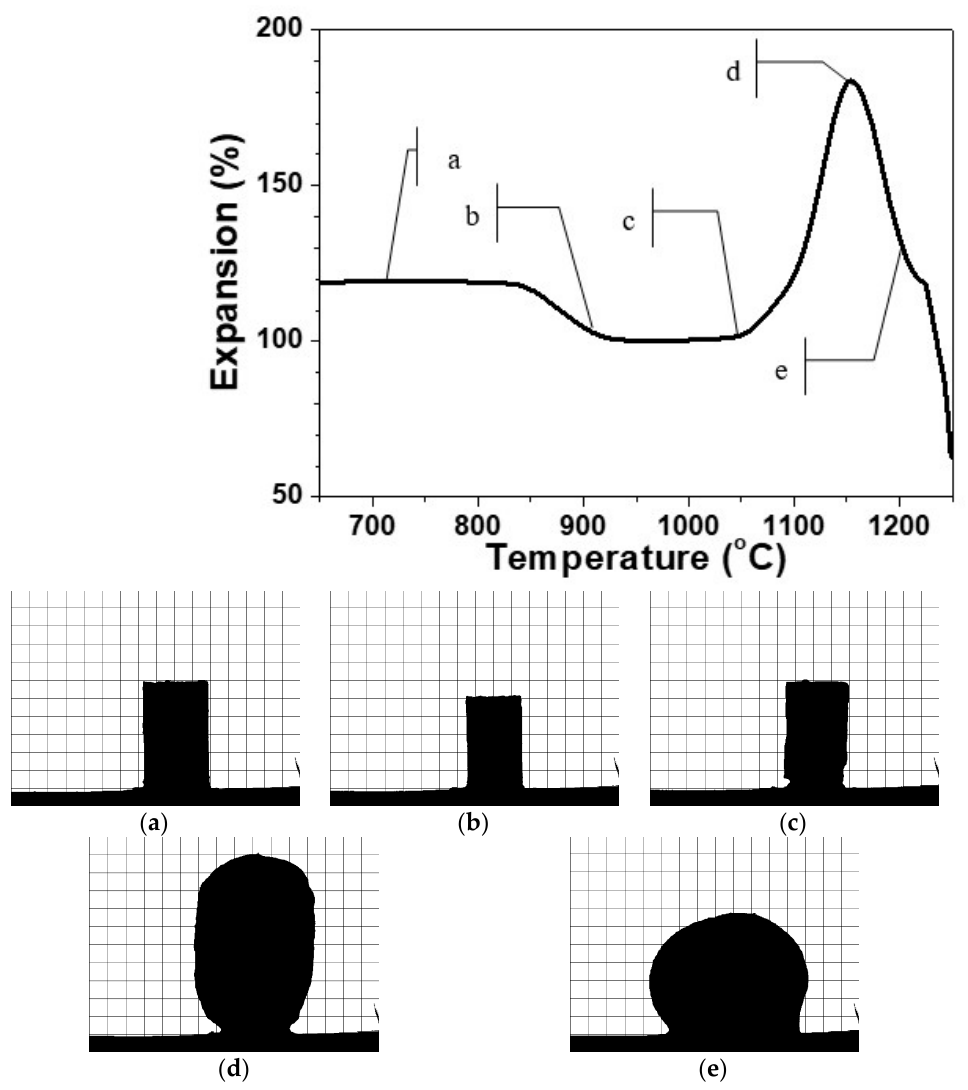
Figure 1. HSM curve of glass ceramic sample at 10 °C min − 1 . Figure 1 a–e: profile optical images of the glass-ceramics at the respective temperature of 700°C( a ), 900 °C( b ), 1050°C( c ), 1150 °C ( d ) and 1200 °C ( e ).